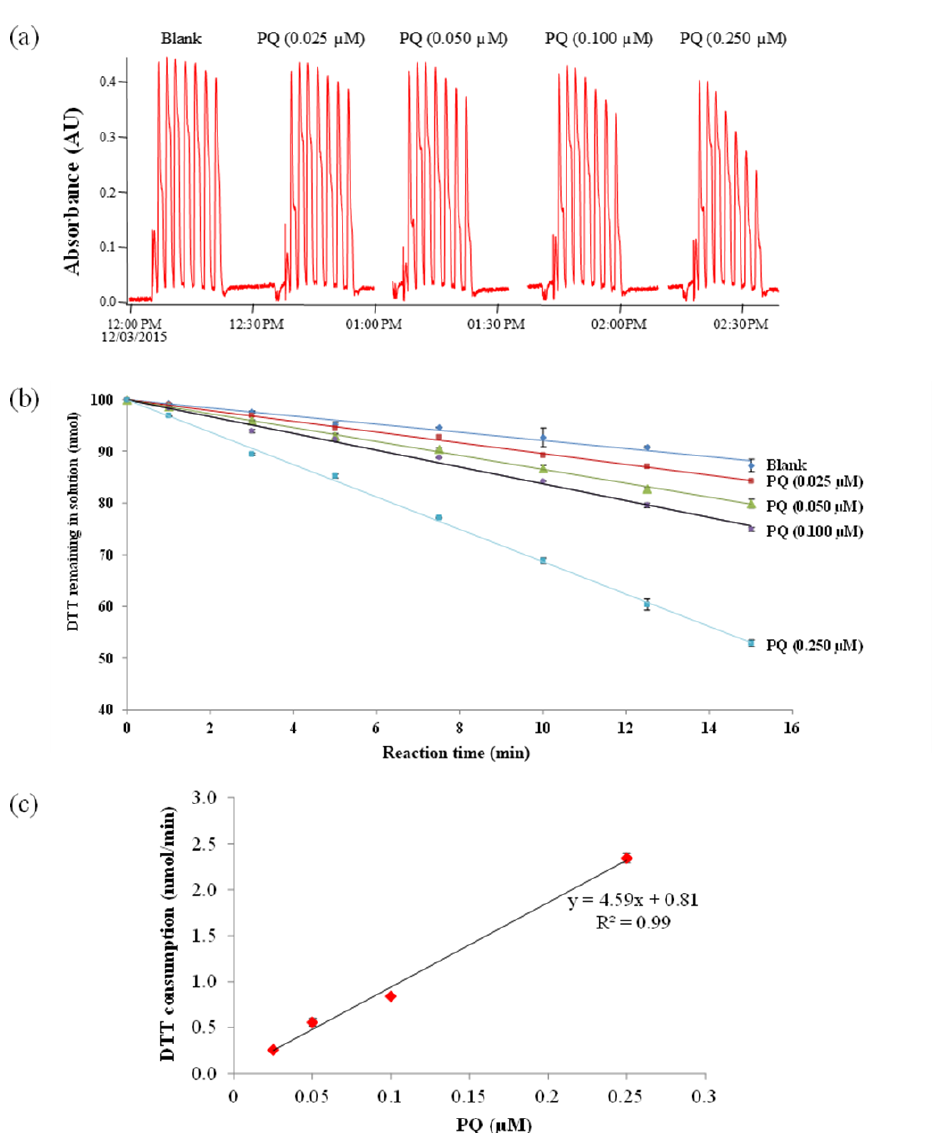
Figure 5. Laboratory evaluation and performance of the automated system for different PQ solutions and blanks: (a) raw intensity signal (AU); (b) DTT remaining in solution at each reaction time (nmol); (c) correlation between DTT consumption rate (nmolmin − 1 ) and PQ concentration